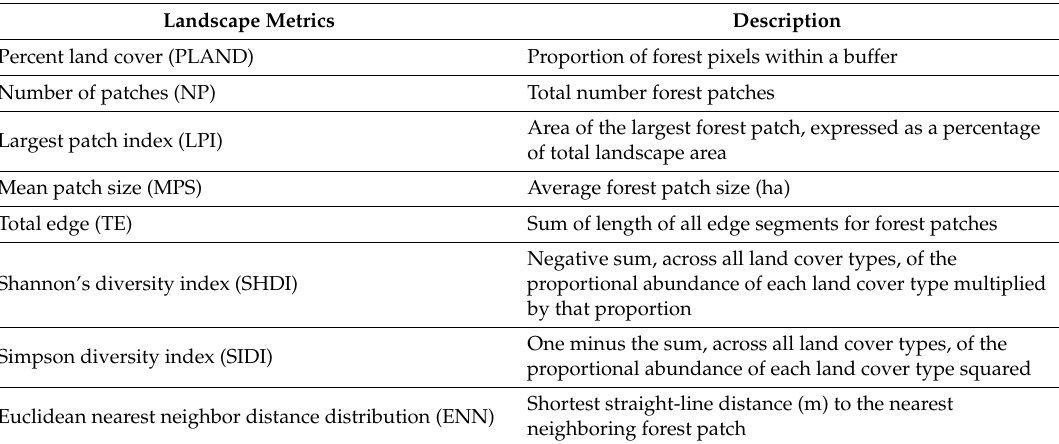
Table 1. Description of landscape metrics, modified from